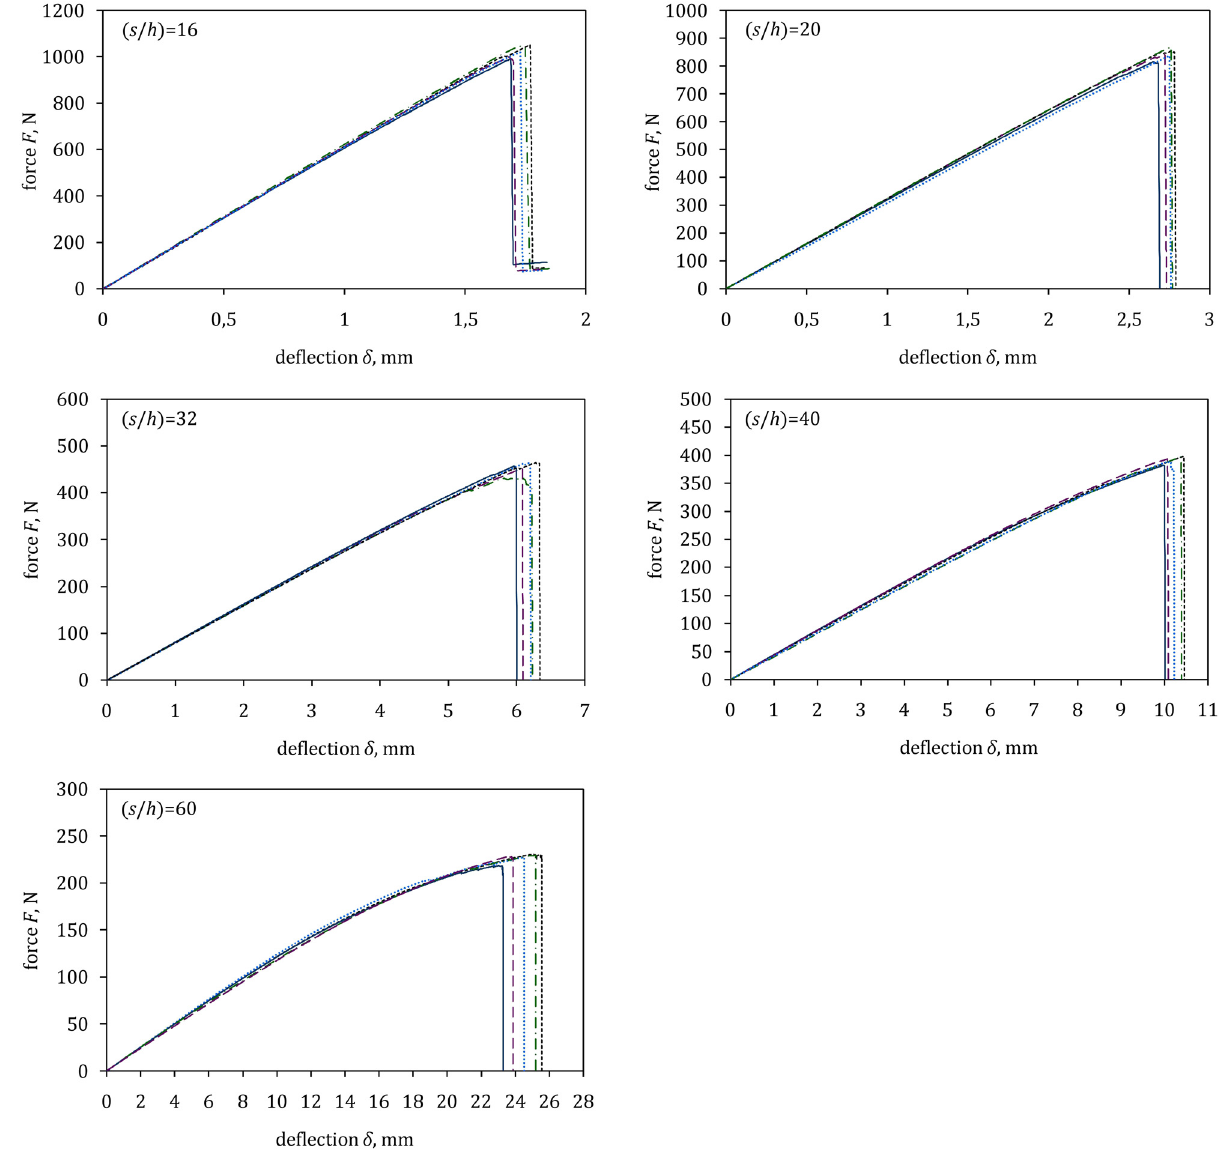
Figure 6: Flexural force – de fl ection responses of the on - axis specimens for various values of ( s / h )